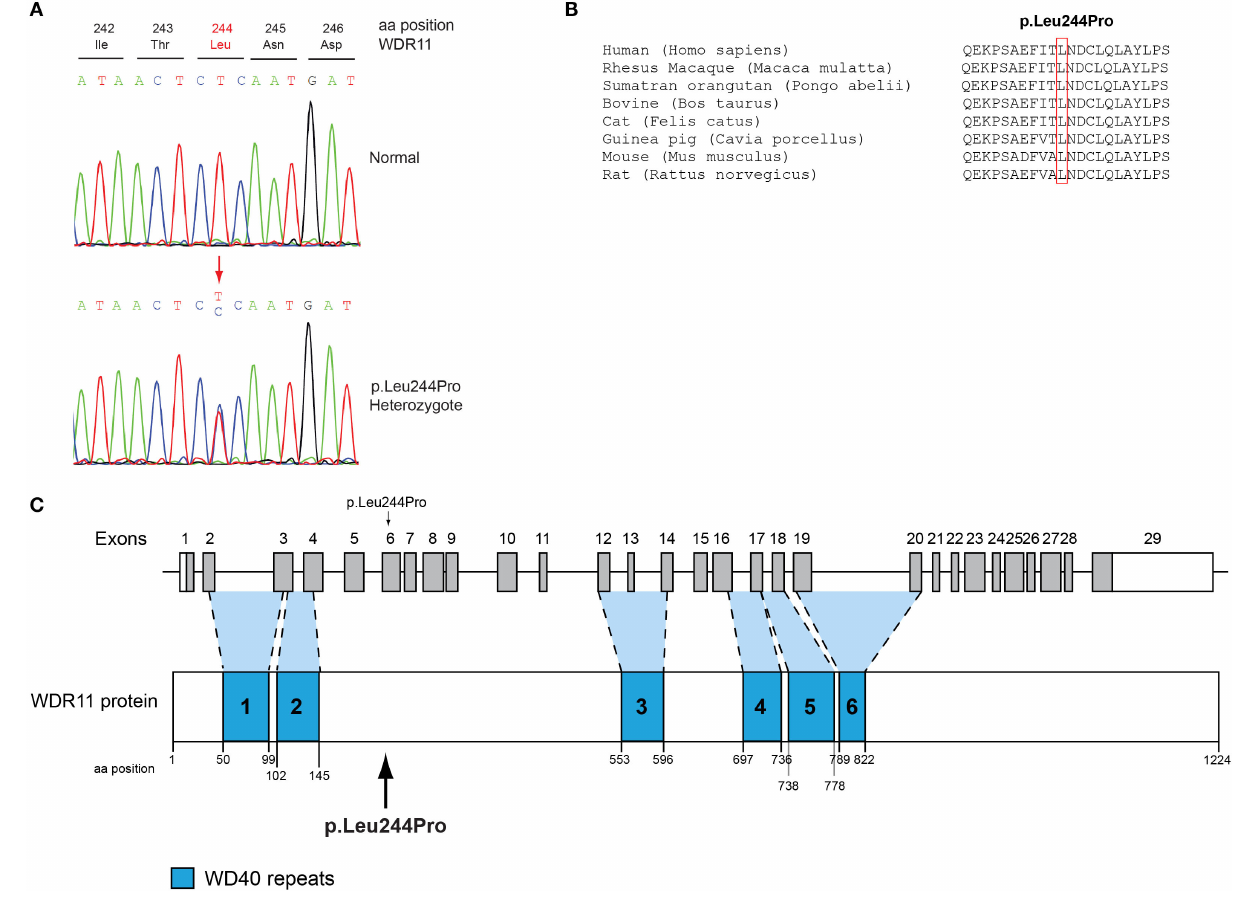
CHD7 gene, the p.Pro186Ala and p.Arg822Cys of the FGFR1 gene, the p.Ile179Thr of the SRA1 gene, the p.Arg561Gly of the POLR3A gene and the p.Arg112gGln of the PROP1